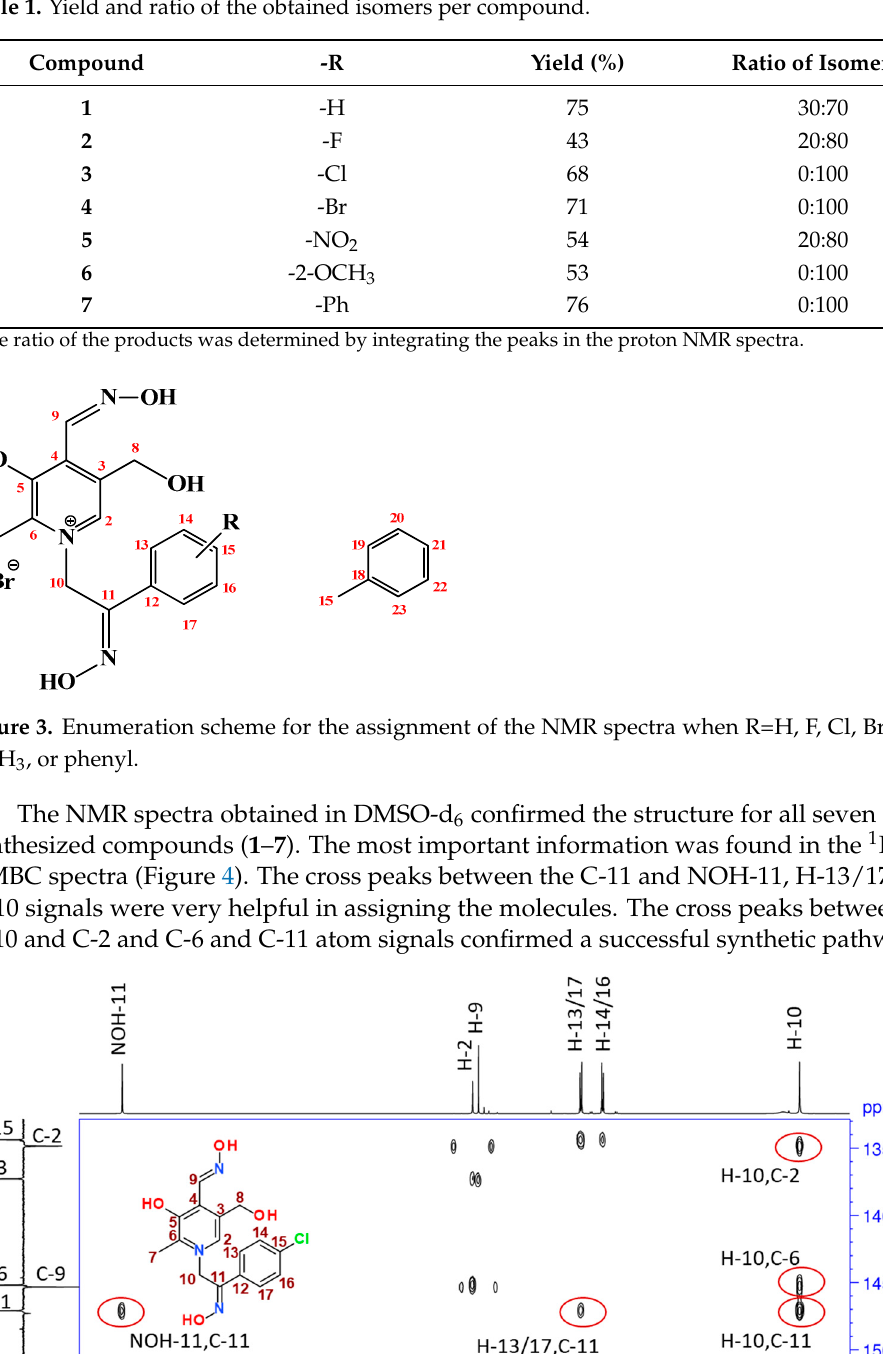
Figure 2. Schematic presentation of the S N 1 mechanism occurring in pyridoxal dioxime synthesis.